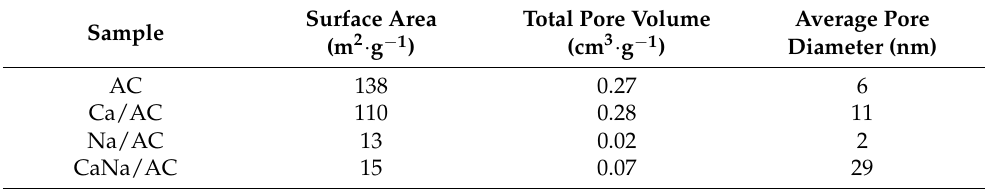
Table 2. Surface area, total pore volume, and average pore diameter of AC, Ca/AC, Na/AC, and